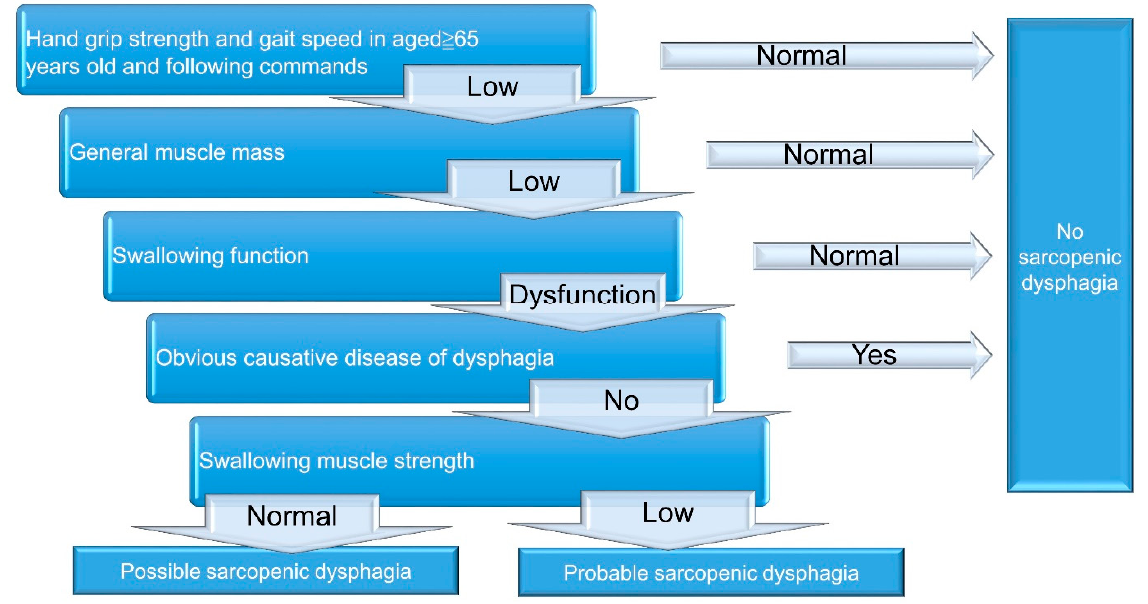
The results of imaging tests (computed tomography, magnetic resonance imaging, ultrasonography) are consistent with loss of swallowing muscle mass 4 The causes of dysphagia are excluded except for sarcopenia 5 The main cause of dysphagia is considered to be sarcopenia